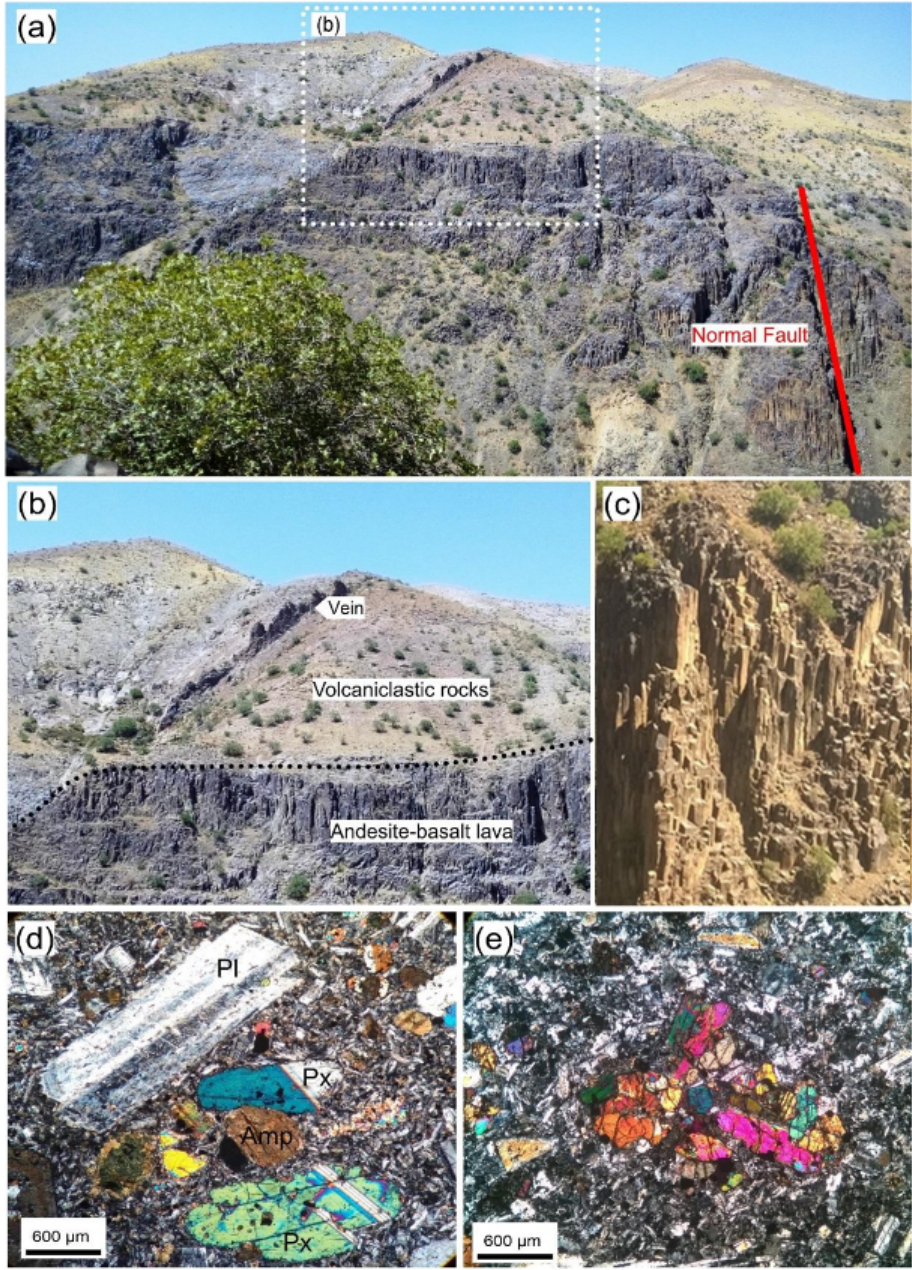
Figure 4. Field photographs and photomicrographs of Shah-Ali-Beiglou area: ( a , b ) Outcrop of ore-bearing vein, volcaniclastic rocks, and andesite–basalt lava; ( c ) Columnar structure in andesite–basalt lava; ( d ) Porphyric texture consisting of phenocrysts of plagioclase (Pl), pyroxene (Px) and Amp (Amp) in the matrix of microcrystalline plagioclase and clinopyroxene; ( e ) Glomeroporhyritic texture of pyroxene crystals in a fine grained matrix of plagioclase and pyroxene crystals in andesite-basalt